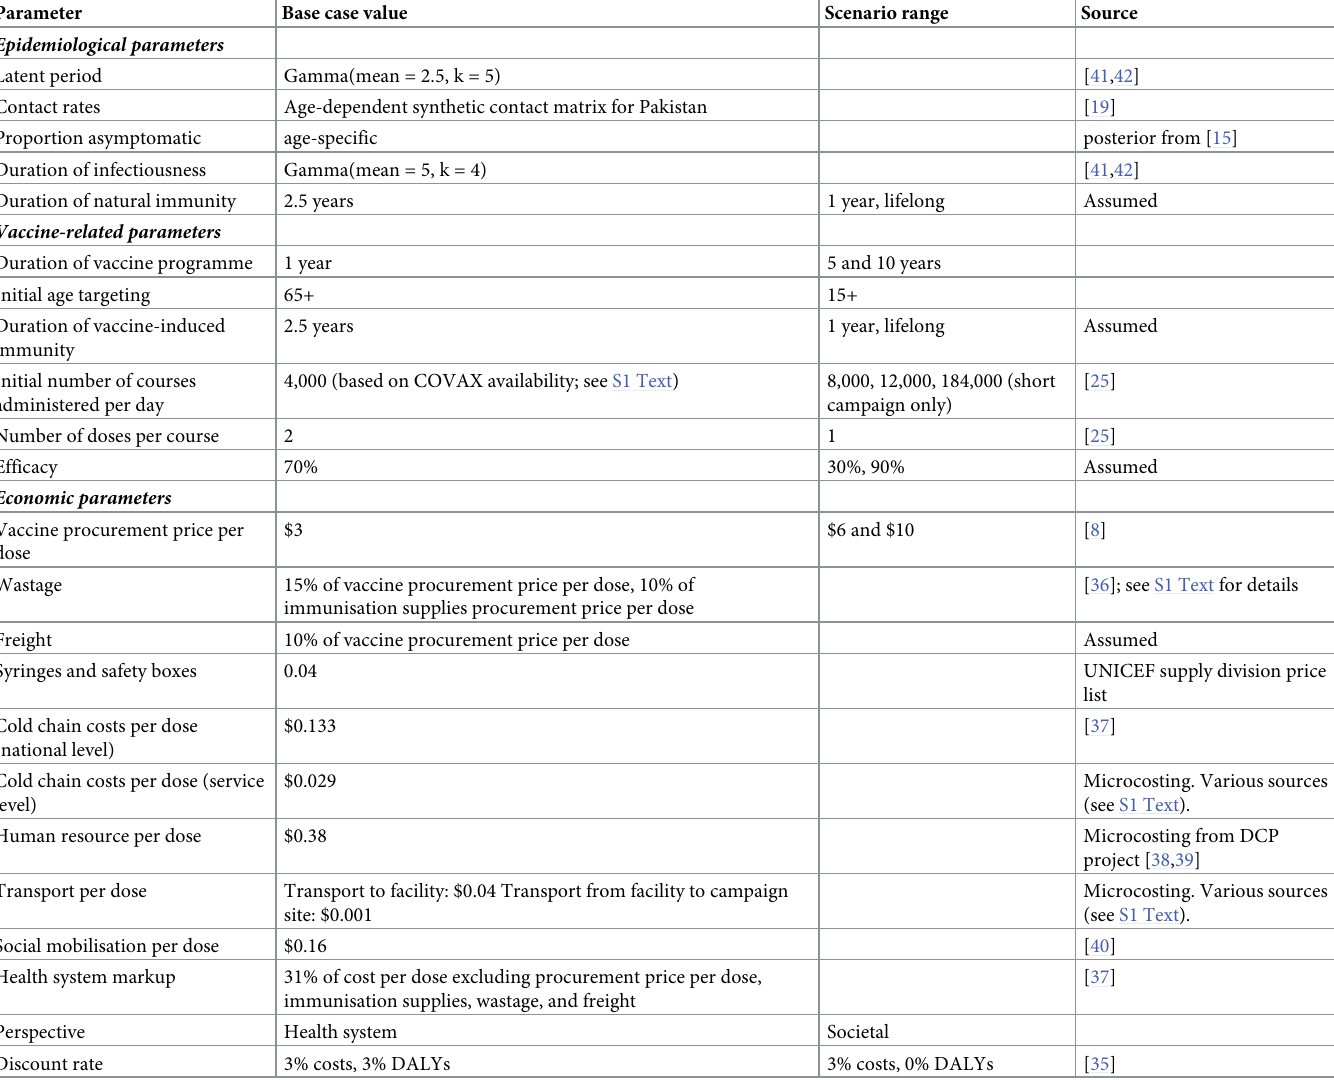
Table 1. Summary of epidemiological, vaccine, and economic parameters used in the base case and scenario